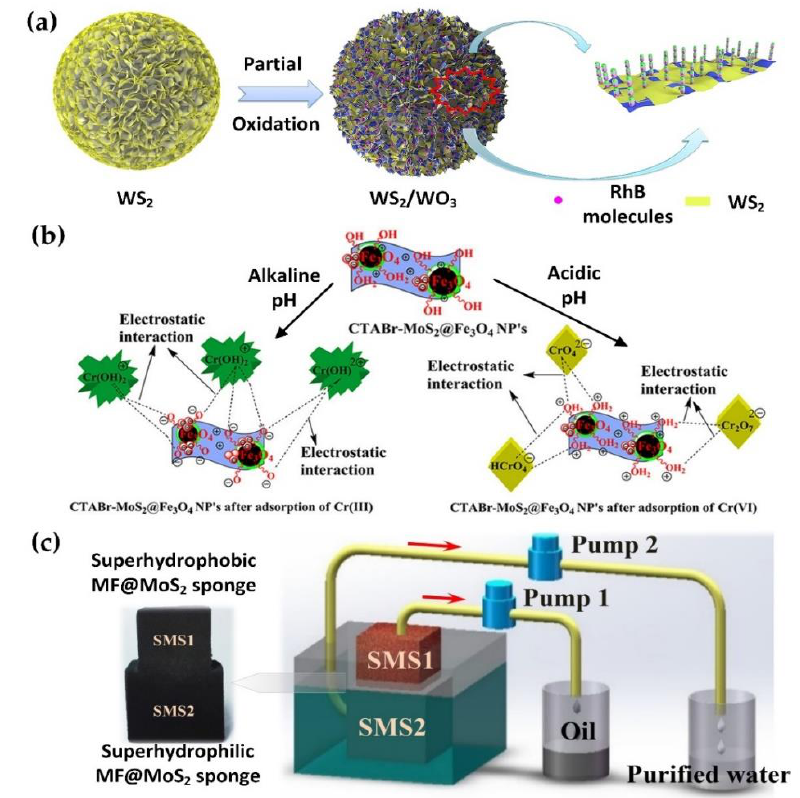
Figure 6. ( a ) Facile oxidation strategy to prepare a flower-like WS 2 / WO 3 heterostructure for adsorbing RhB from wastewater (Reproduced with permission from [182]. Copyright 2020 MDPI AG CC-BY 4.0). ( b ) Bifunctional cetyltrimethylammonium bromide (CTABr)-coated MoS 2 -decorated Fe 3 O